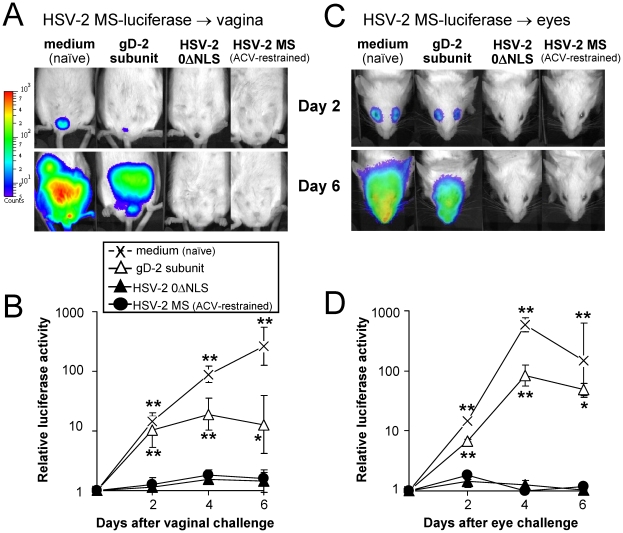
Vaccine-induced protection against HSV-2 MS-luciferase infection.(A and C) Mice were treated with 2 mg medoxyprogesterone 7 and 3 days prior to vaginal HSV-2 challenge [54]. On Day 130 p.i., mice were challenged with (A) 500,000 pfu per vagina or (C) 100,000 pfu per eye of HSV-2 MS-luciferase, and were anaesthetized and injected with 3 mg D-luciferin substrate at times post-challenge for imaging in a bioluminescent imager. Not shown in panels A or C are the age- and sex-matched, uninfected control mice included in these analyses that were anaesthetized and injected with 3 mg D-luciferin substrate at the same time, and which served as a background control to define the background level of light emission recorded from each mouse by the bioluminescent imager. (B and D) Mean ± sem of luciferase activity in mice challenged in the (B) vagina or (D) eyes with HSV-2 MS-luciferase, as measured by the fold-increase in light emission from each mouse relative to an uninfected background control mouse injected with 3 mg D-luciferin substrate. In the vaginally challenged group, each datum point represents the mean ± sem of luciferase activity based on ∑n = 5 per group (n = 3 challenged on Day 50 p.i. and n = 2 challenged on Day 130 p.i.). In the ocularly challenged group, each datum point represents the mean ± sem of luciferase activity based on ∑n = 4 per group (n = 2 challenged on Day 50 p.i. and n = 2 challenged on Day 130 p.i.). A single asterisk (*) denotes p<0.05 and a double asterisk (**) denotes p<0.001 that luciferase activity in HSV-2 MS-luciferase-challenged mice was significantly different from uninfected control mice injected with 3 mg D-luciferin, as determined by one-way ANOVA and Tukey's post hoc t-test. In both vaginal and ocular challenge tests, luciferase activity was significantly different between gD-2- and 0ΔNLS-immunized mice (p<0.0001; two-sided, paired t-test).